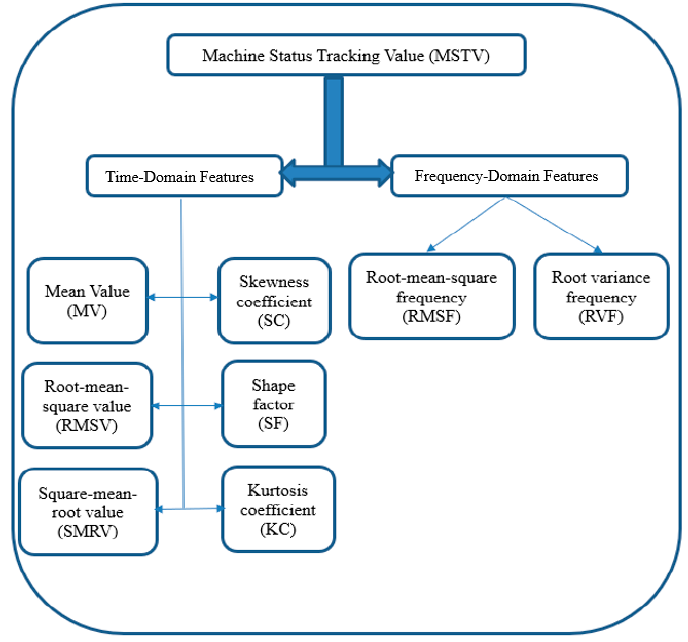
Figure 8. Structure of feature extraction in Time-domain and Frequency-domain features.